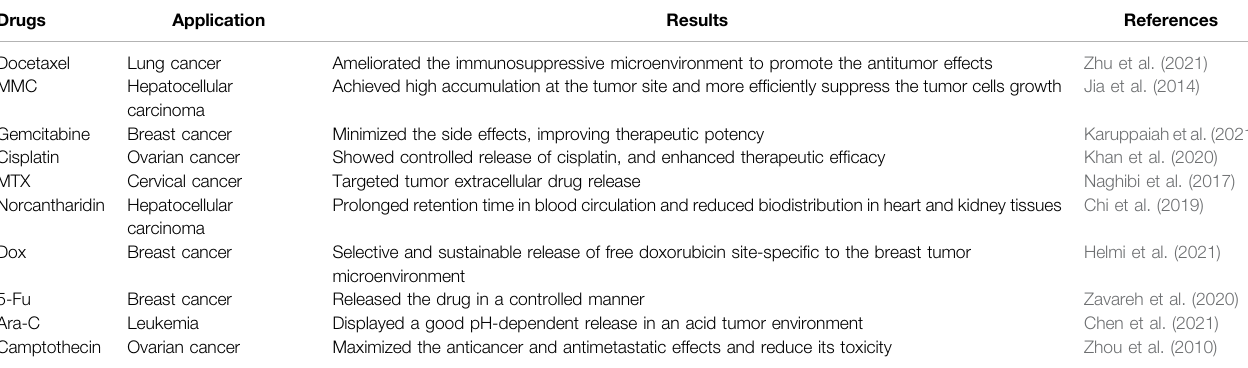
TABLE 1 | A few examples of chitosan based chemotherapeutic drugs nanoparticles and their application in oncotherapies.